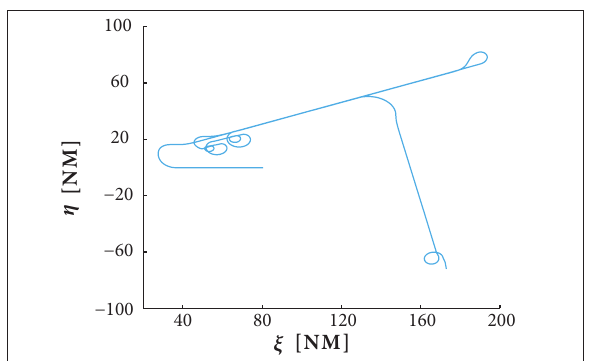
Figure 1. Flight inspection 2-D